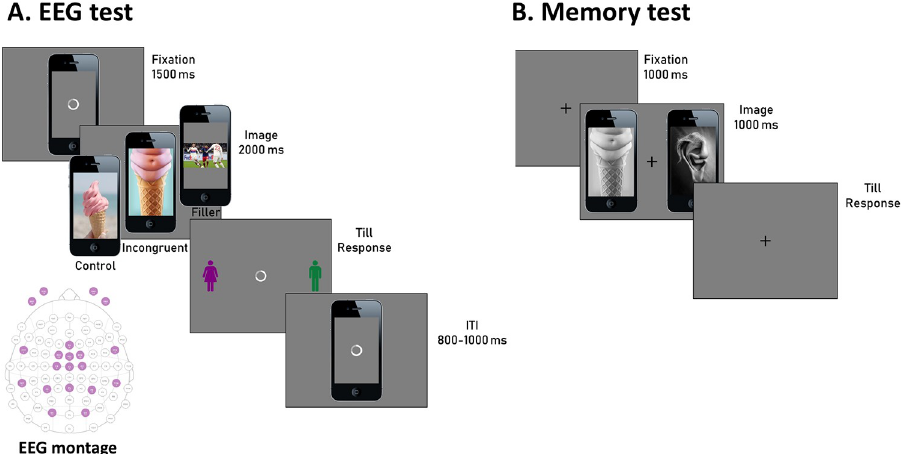
Fig 1. A . Schematic representation of a trial during the EEG recording session. A trial started with a 1500 ms fixation (loading wheel), followed by the target image (incongruent, control or filler) presented for 2000 ms. A response screen prompted the participants to choose whether they thought the presented image was directed to females or males (the position of the icons was chosen randomly at each trial) and lasted till the response was provided. The next trial started after a variable inter-trial interval (ITI) randomly jittered between 800 and 1000 ms. A representation of the 16 EEG electrodes montage is also provided. B . Schematic representation of the memory test performed about one week after the EEG test. Participants were asked to fixate on a fixation presented for 1000 ms, before the image pair appearance. They had to choose which of the presented images (both incongruent and control) had been presented the week before during the EEG